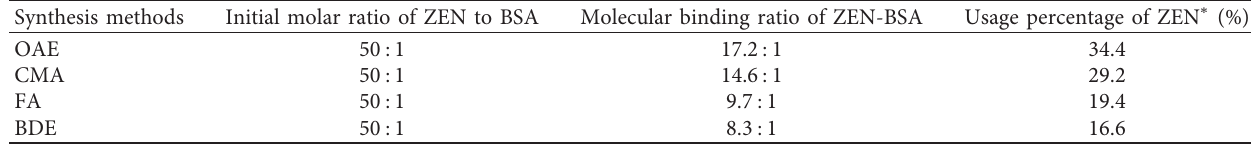
Table 1: Molecular binding ratio of ZEN-BSA prepared via the four methods.